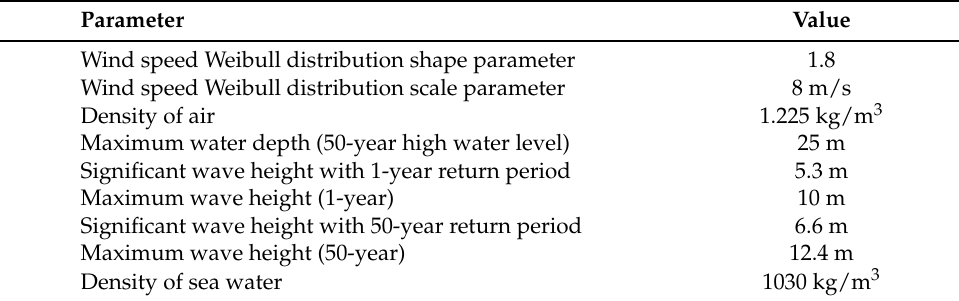
Table 2. Metocean data [39].